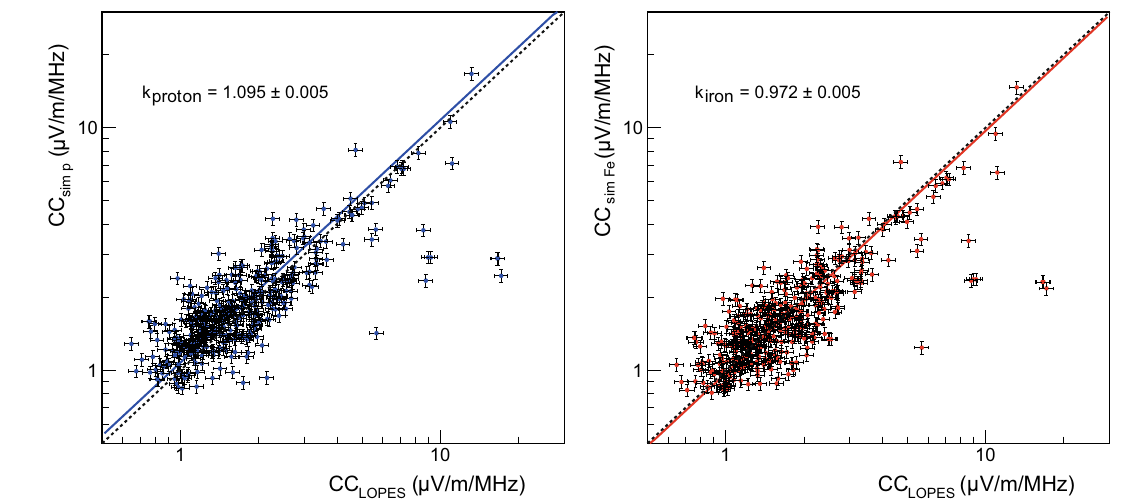
correlation (solid lines), which is in both cases smaller than the calibra- tion scale uncertainty of 16%. The outliers are mostly the same events as in Fig. 12